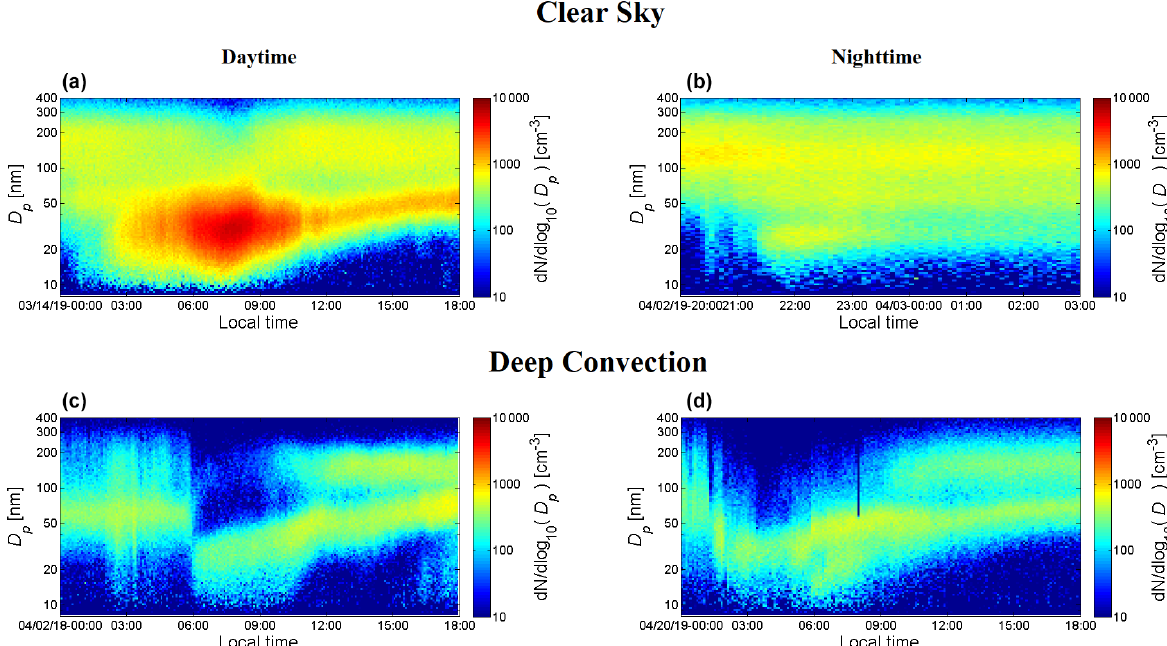
Figure 10. Selected particle growth events according to the Tir value at the onset of the event. Events under clear-sky/shallow-cloud con- ditions during daytime (a, c) and nighttime (b, d) were selected based on Tir > 281K (third quartile), while deep-convection events were chosen based on Tir < 228K (first quartile).